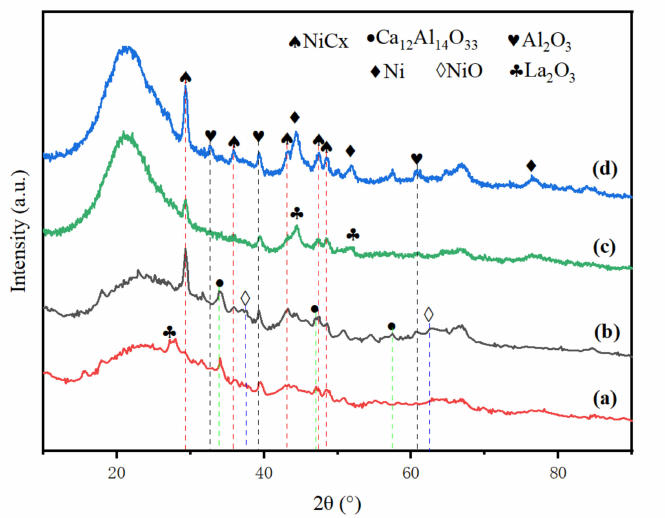
Figure 2. XRD patterns for catalysts: ( a ) fresh Ni-La/ACC(M); ( b ) fresh Ni/ACC(M); ( c ) used Ni-La/ACC(M); ( d ) used